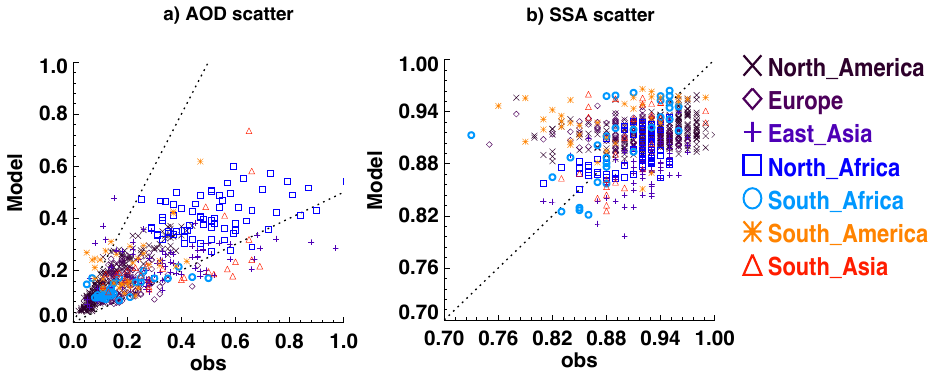
Fig. 22. Scatter plots of simulated monthly AOD and SSA in comparison with AERONET data. Results from several different regions (North America, Europe, East Asia, North Africa, South Africa, South America, and South Asia) are represented by 7 different colours and marks. The upper and lower dash lines in (a) are 2:1 and 1:2, respectively. The dash line in (b) is 1:1. See Table 7 for normalized model mean bias, and the correlation coefficients between the model and